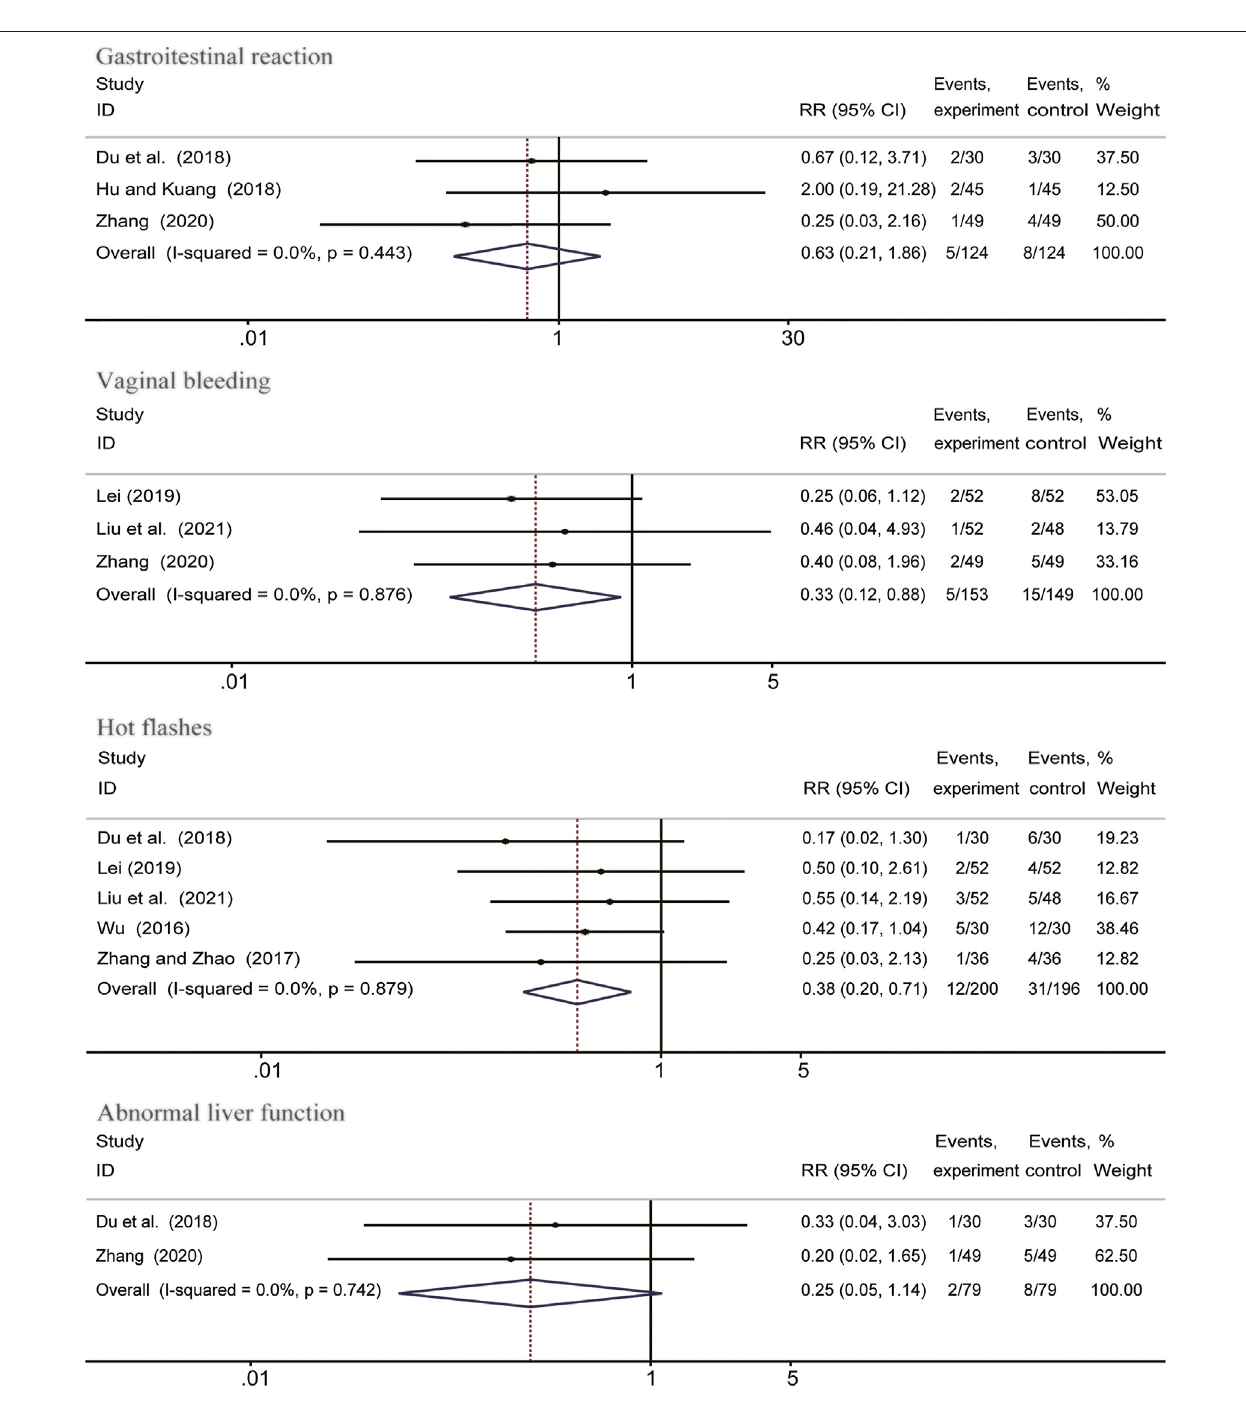
FIGURE 5 | Forest plots showing comparision of adverse events comparing Salvia -containing CHM combined with GnRH-a to GnRH-a alone treatment.